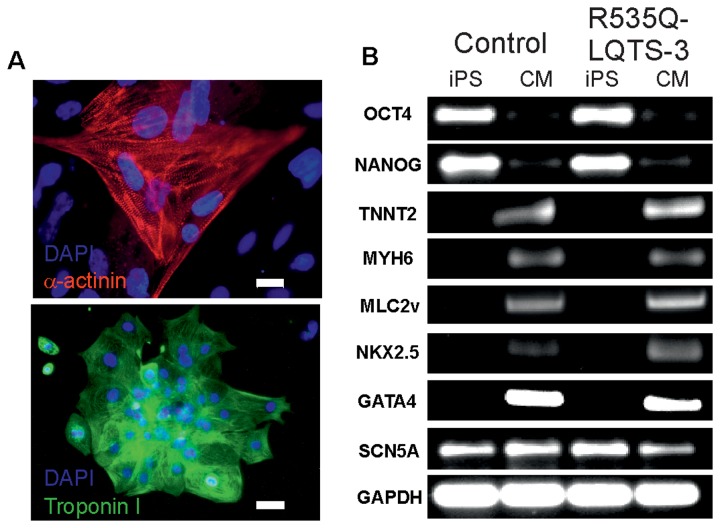
Expression of cardiac markers in R535Q-LQTS-3 iPS cell-derived CM.(A) Immunocytochemical analysis of cardiac markers α-actinin (red) and troponin I (green). Nuclei were counterstained with DAPI (blue). Scale bars: 20 μm (α-actinin) and 100 μm (troponin I). (B) The analysis of expression levels of cardiospecific transcripts was done by RT-PCR showing that the R535Q-LQTS-3 iPS cell-derived cardiomyocytes express cardiac transcripts at a similar level as their human ES cell-derived counterparts.